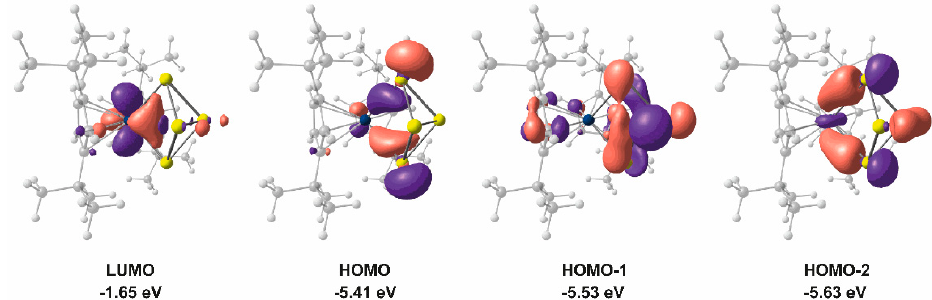
Figure 1. Frontier molecular orbitals (canonical orbitals) of [Cp’’ 2 Zr( η 1:1 -As 4 )] ( 1 ) at the B3LYP/def2TZVP level of theory.